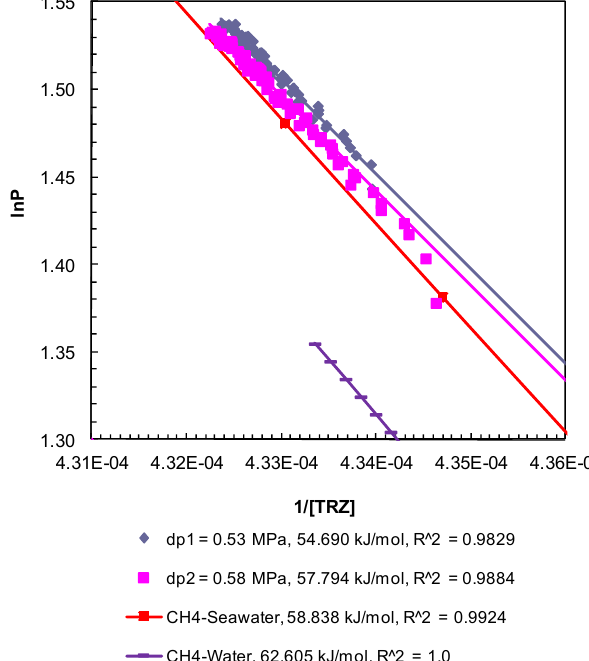
Figure 5. Post-depressurization (dps1 and 2) P - T conditions from Experiment 1 plotted as ln P against 1/[ T R Z ]. The Clausius-Clapeyron equation was used to calculate the enthalpy of dissociation ( ∆ H in kJ/mol) of methane hydrates from seawater in porous media at a hyd confining pressure of 10.44 MPa. Equilibrium conditions of bulk methane hydrates-water obtained from CSMGem and those for bulk methane hydrates-seawater obtained from . The R 2 values indicate the Duan and Sun [18] were used to calculate the theoretical ∆ H hyd correlation coefficient for linear regression performed to compute the slope as ∆ H hyd